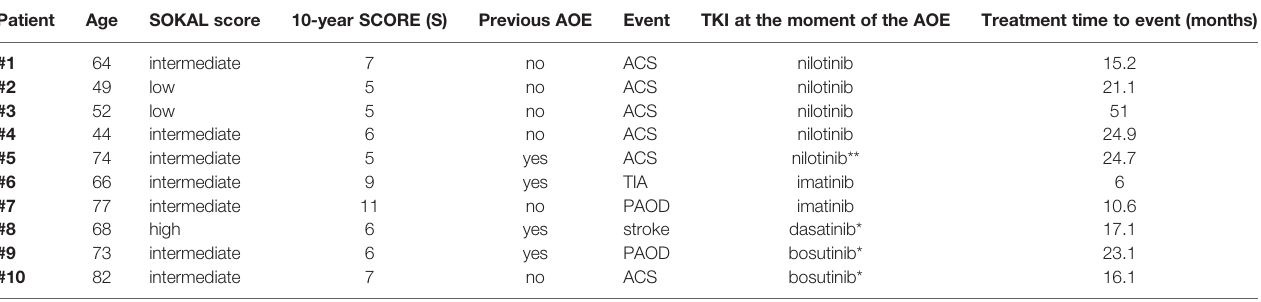
TABLE 3 | Patients who experienced